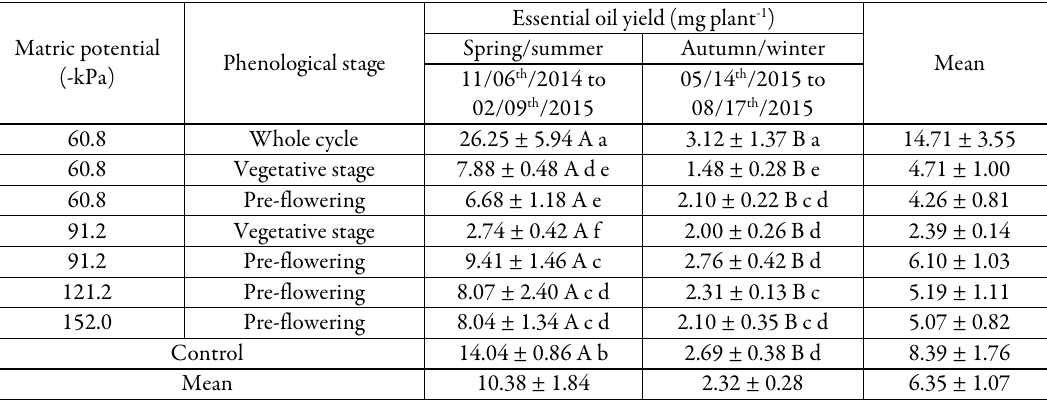
Table 8. Season effect on the yield of Origanum vulgare L. essential oil Matric potential